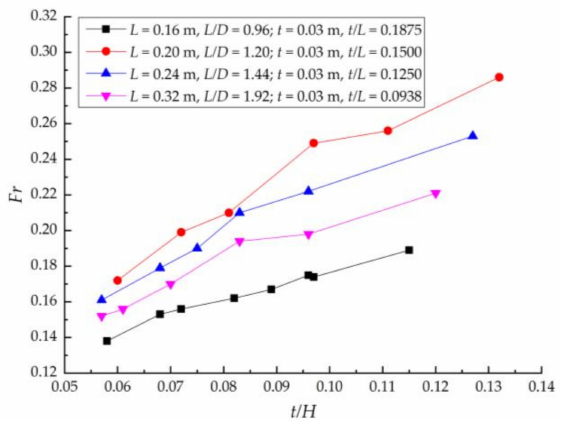
Figure 5. Relationship between critical Fr and t / H